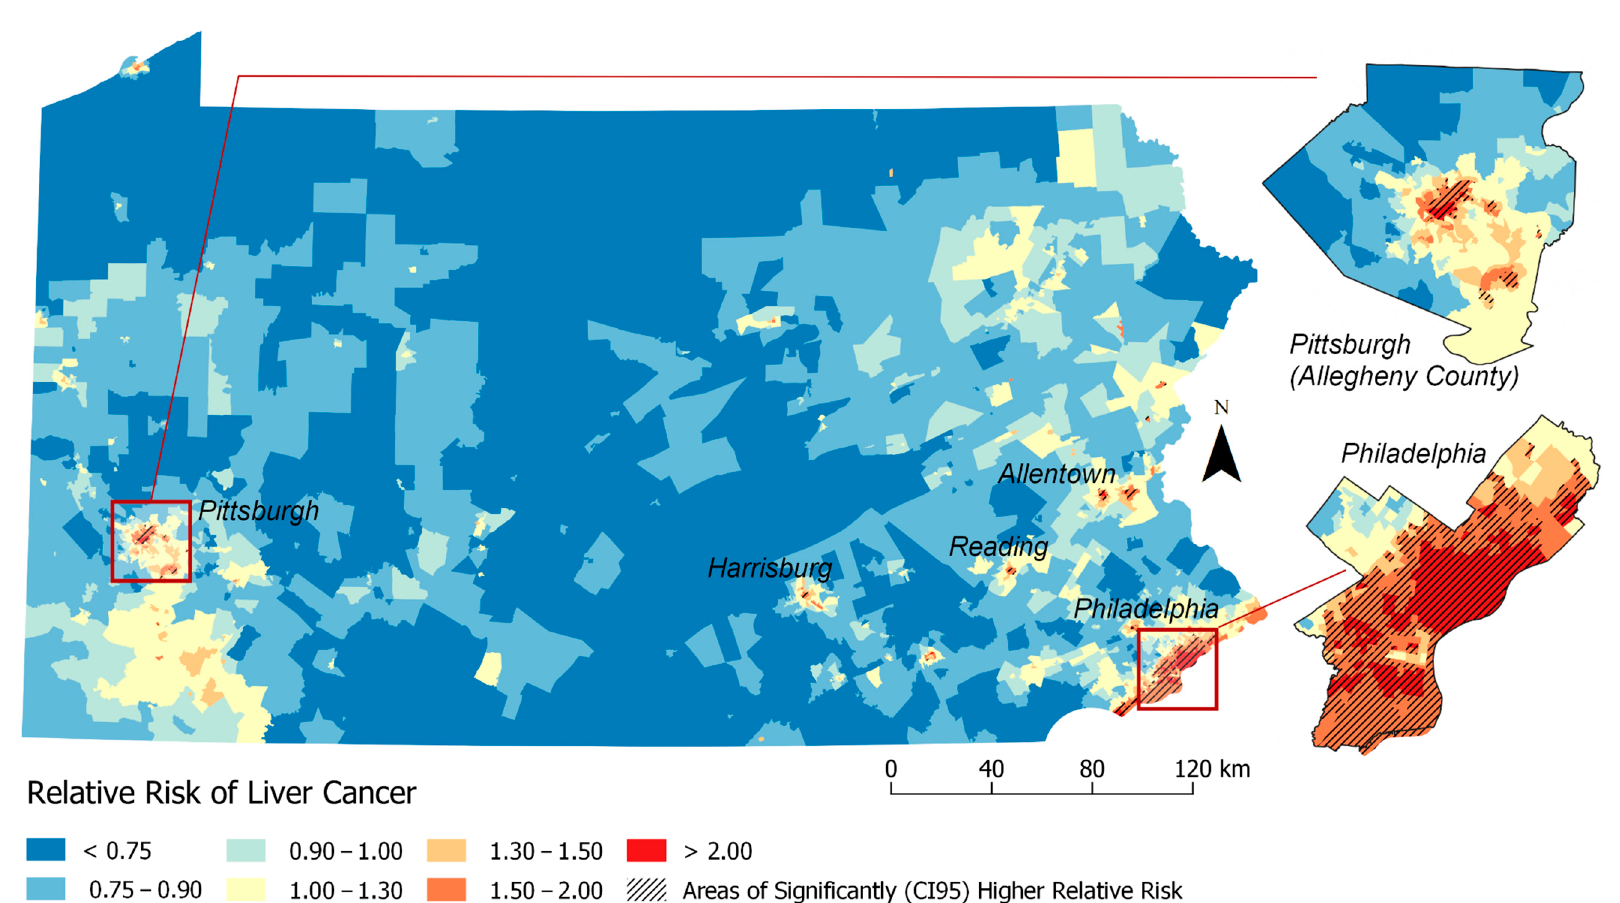
Figure 1. Relative Risk Estimates for Liver Cancer by Census Tract Adjusted for Individual-level factors only (Model 1: Adjusted for: individual-level factors (age + gender + year + race)). RR > 1 indicates elevated risk of liver cancer incidence. Shaded areas indicate significant clusters of higher than expected rates of liver cancer based on the 95% credible interval (CI 95).